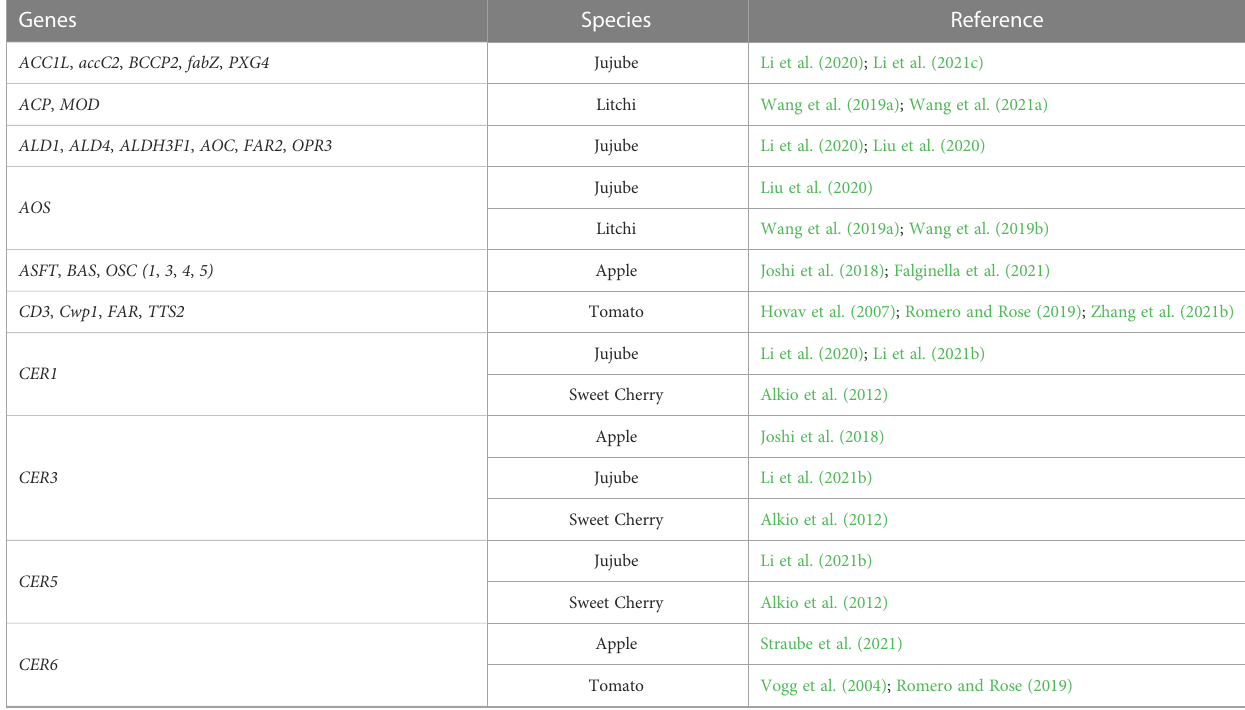
TABLE 3 Potentially cracking-related genes involved in cuticular waxes biosynthesis.